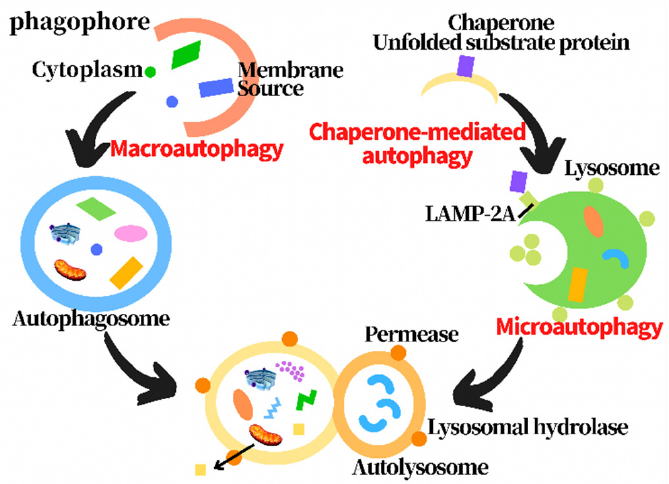
Figure 1. Diagram of three types of autophagy